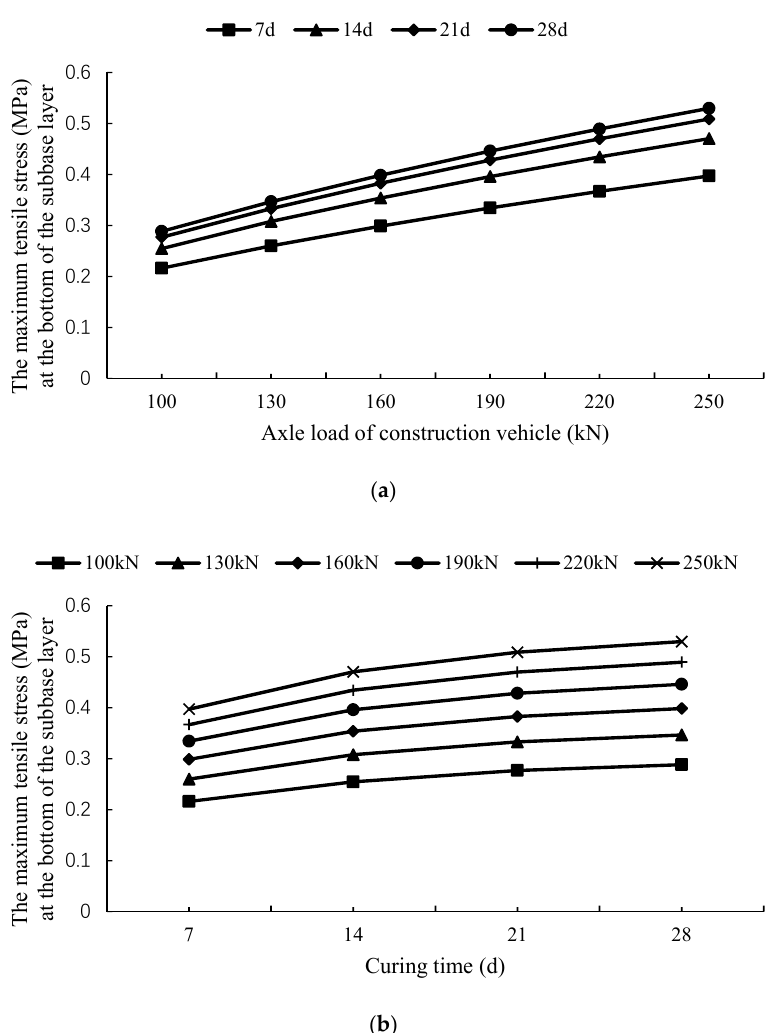
Figure 11. The maximum bottom tensile stress calculated under different conditions: ( a ) Relationship between different loads and the maximum bottom tensile stress; ( b ) relationship between different curing times and the maximum bottom tensile stress.